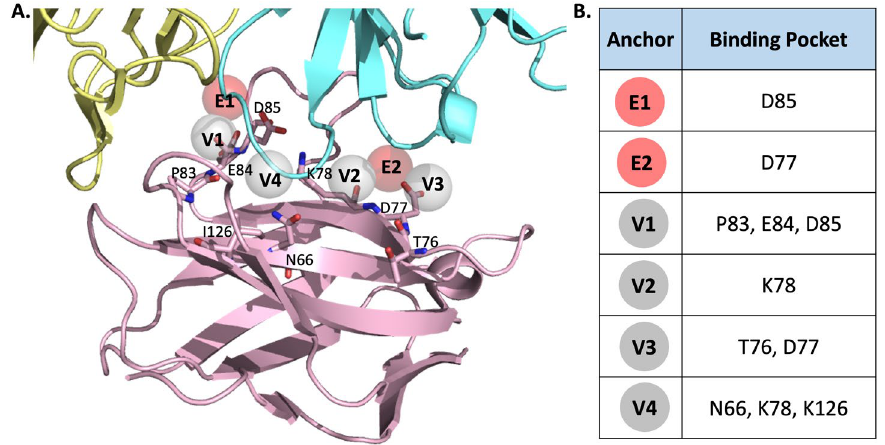
Figure 1. Anchors obtained from SiMMap. ( A ) The structure of the human PD-1 in complex with pembrolizumab Fv (5B8C) is depicted as a cartoon and six anchors as transparent spheres. PD-1 is colored in pink, while the light and heavy chains of pembrolizumab are colored in yellow and cyan, respectively. Red E1 and E2 represent the electrostatic force; gray V1, V2, V3 and V4 represent van der Waals forces. The corresponding binding pockets (residues) are represented as sticks. ( B ) The table presents binding pockets for each